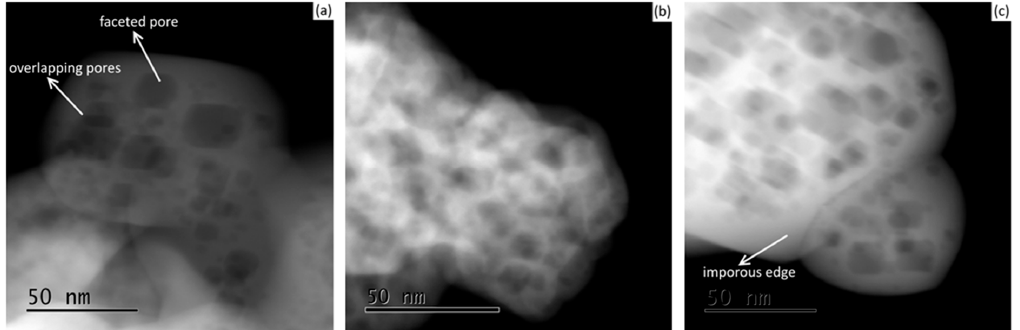
Figure 2. TEM images of 7 YSZ powder indicating YSZ particles containing pores: ( a ) before calcination; and after calcination at ( b ) 973 K, and ( c ) 1373 K for 2 h.